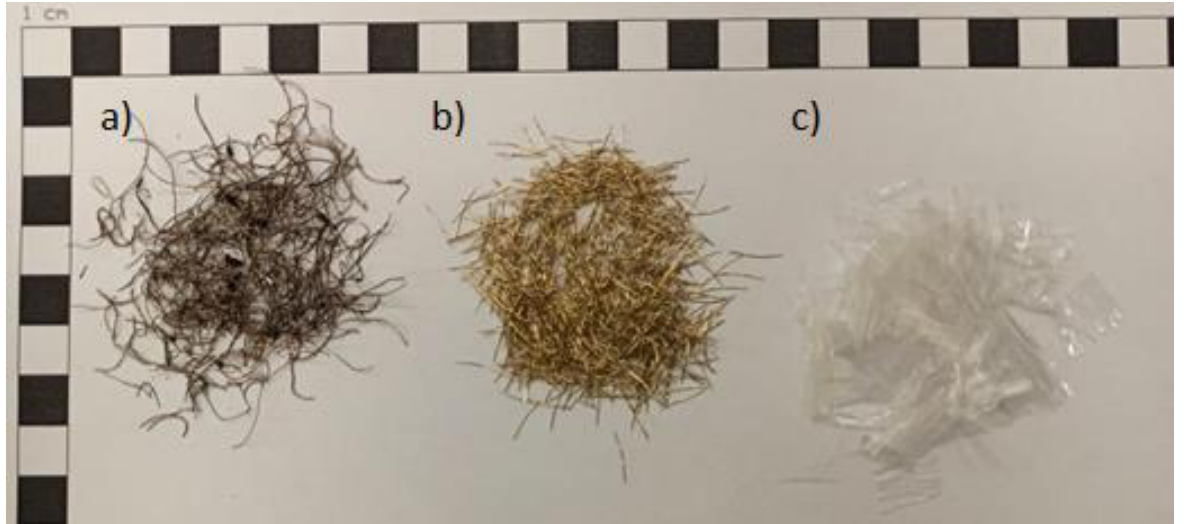
Figure 2. ( a ) Steel cord, ( b ) steel microfibers, and ( c ) polypropylene microfibers.